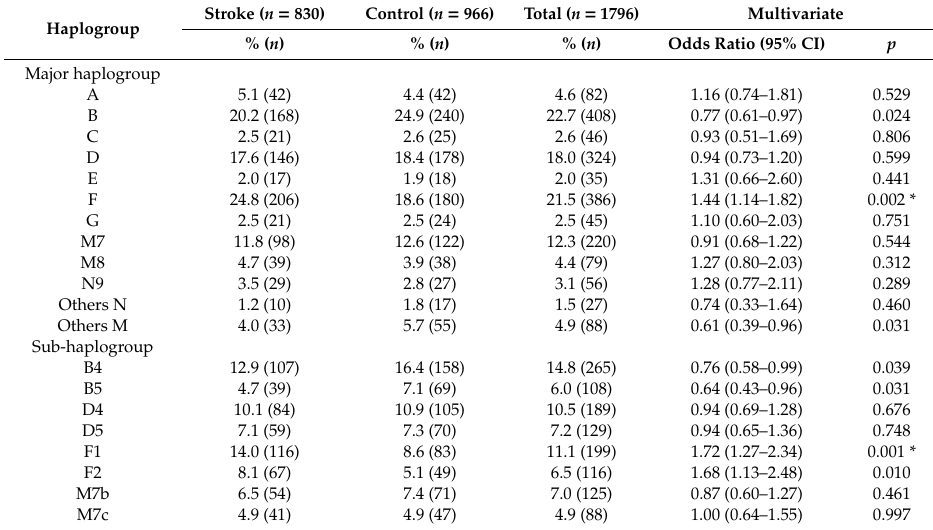
Table 1. Multivariate logistic regression analysis of mitochondrial haplogroups associated with ischemic